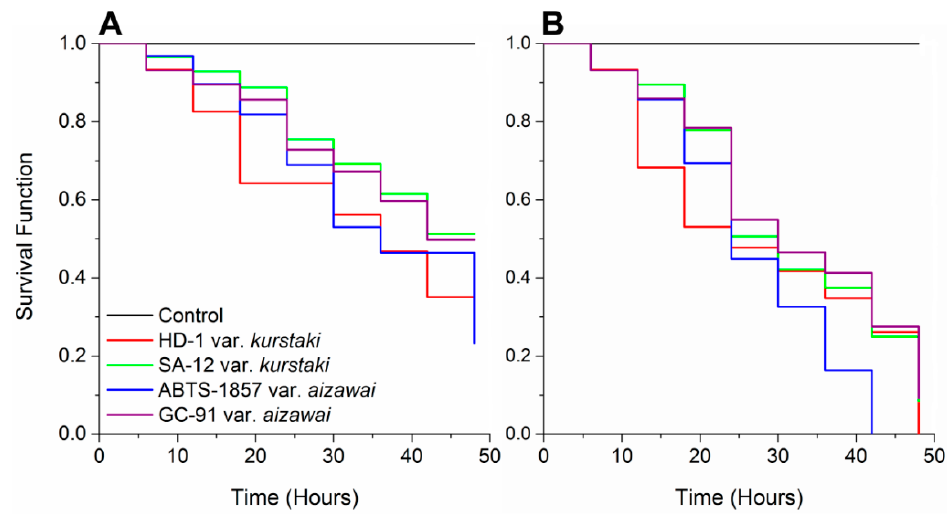
Figure 1. Survival curves of Euprosterna elaeasa caterpillars exposed to Bacillus thuringiensis strains, subjected to survival analyses using the Kaplan–Meier estimators’ log ‐ rank test. Lethal dose of ( A ) LC 50 ( χ 2 = 9.47; p < 0.001) and ( B ) LC 90 ( χ 2 = 18.57; p < 0.001). At LC 90 , the survival rates of E. elaeasa were different according to the treatments (log ‐ rank test, 2 = 18.57, df = 4, p < 0.001), decreasing from 99.9% (control) to 10.13% with SA ‐ 12 var. kurstaki , 9.87% with GC ‐ 91 var. aizawai , and 0% with both the HD ‐ 1 var. kurstaki and ABTS ‐ 1857 var. aizawai (Figure 1B).